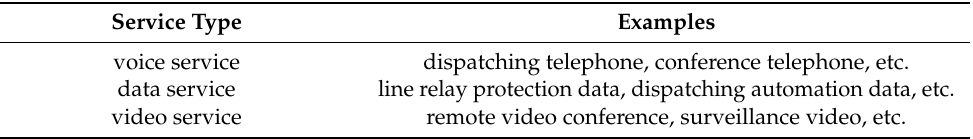
Table 1. Service type of power communication services.